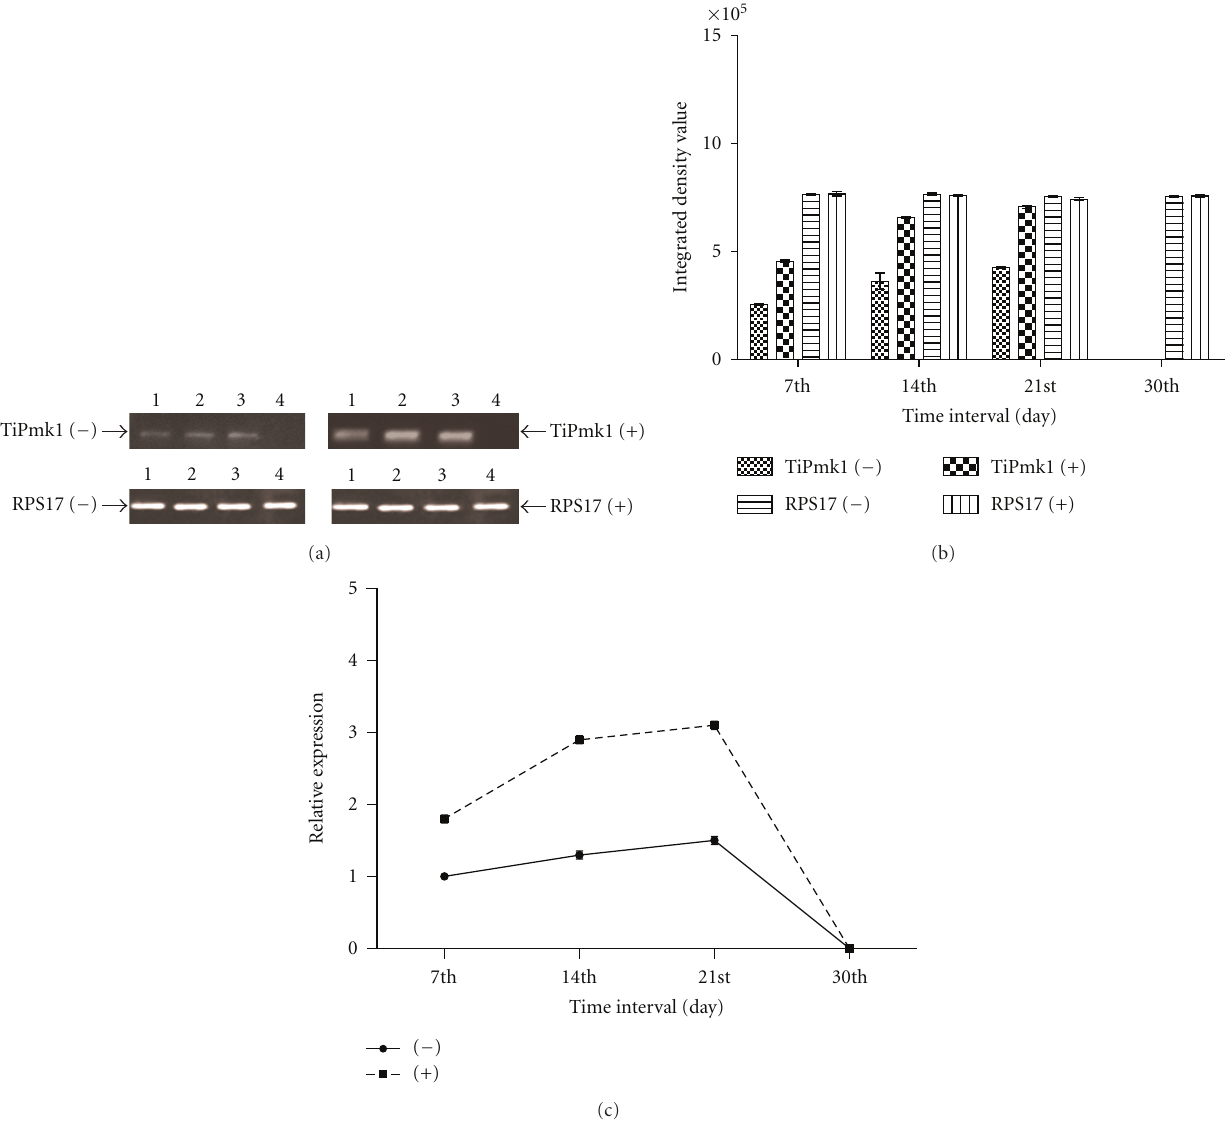
Figure 4: (a, b and c) Expression analysis of TiPmk1 gene in T. indica isolate in absence of host factor ( − ) and in presence of host factor (+) at di ff erent days of growth and development in liquid culture. (a) Semiquantitative RT-PCR analysis—RT-PCR of expressed messenger RNA at the 7th, 14th, 21st, and 30th day (lane 1 to 4, resp.) with RPS17 rRNA transcript used as internal control. (b) Densitometry analysis- integrated density value based on densitometry analysis was done with the help of gene profiler software, Alpha Innotech Corporation USA. (c) Quantitative real-time PCR analysis—relative expression using real-time